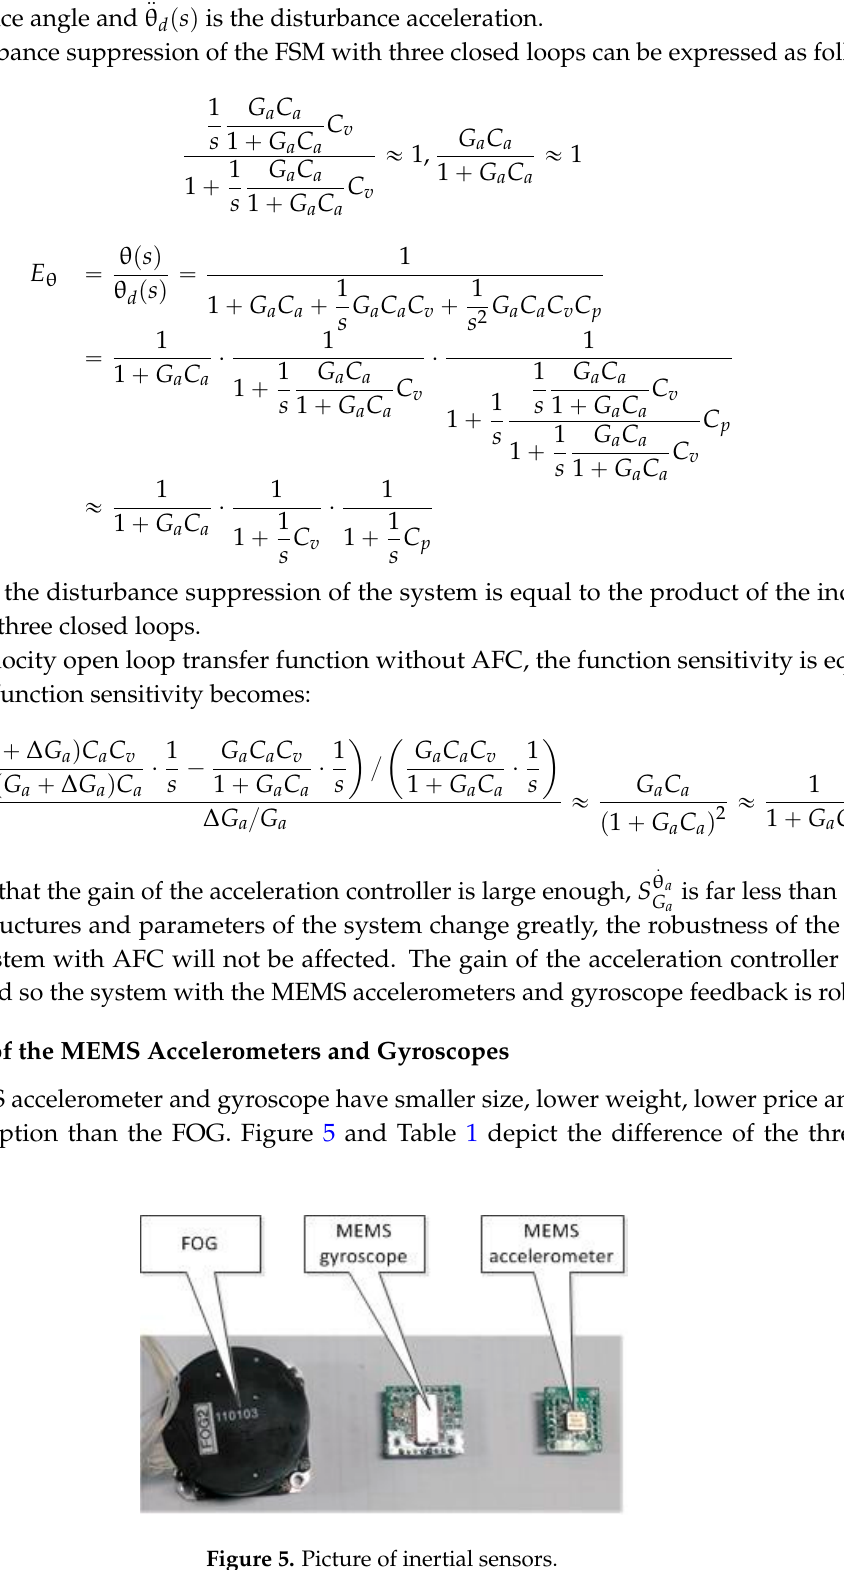
0.1 W Figure 6. FOG noise characteristics. The peak value of the FOG noise is equal to 0.25 °/s, and the RMS value is about 0.037 °/s. Aside from some “spikes”, the amplitude value of amplitude-frequency curve is smooth. The bandwidth of the MEMS gyroscope for the latter experiment is less than 100 Hz, which is lower than that of the FOG. Figure 7 shows the characteristics of the MEMS gyroscope noise. Figure 7. MEMS gyroscope noise characteristics. 1